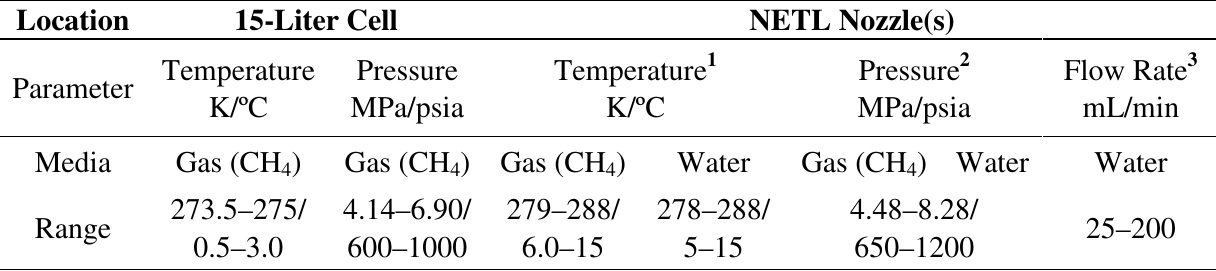
Table 6. NETL 15-Liter Cell rapid methane hydrate formation experimental